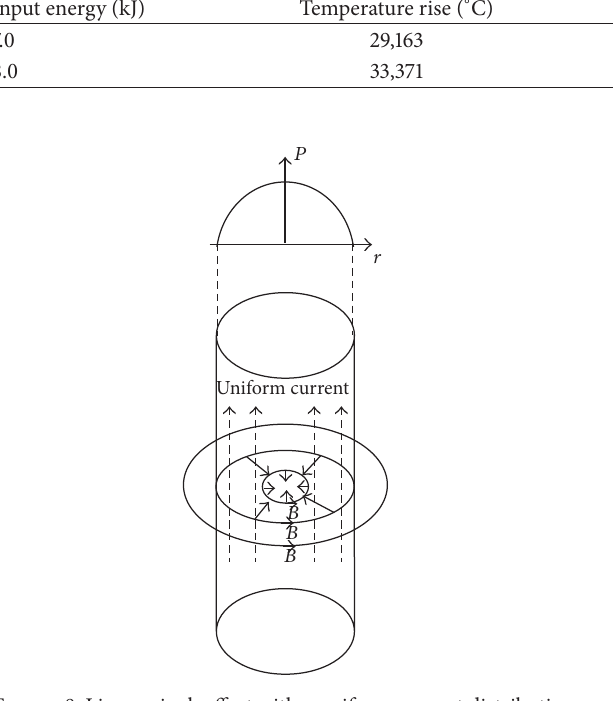
Figure 8: Linear pinch effect with a uniform current distribution.